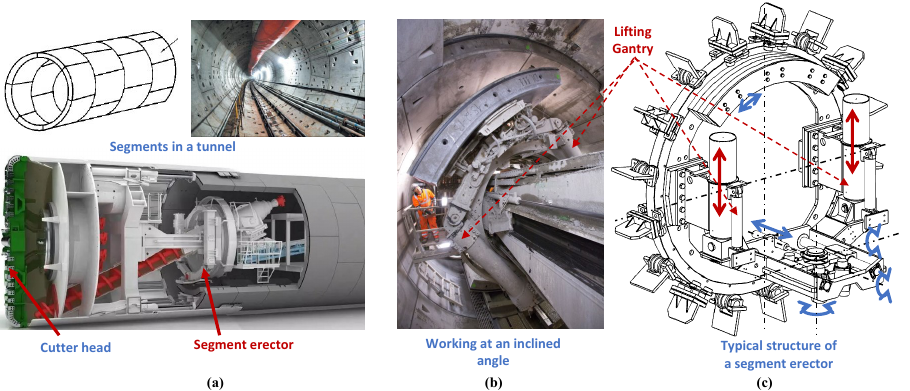
Figure 1. Background about the segment erector in a shield tunneling machine in practice. ( a ) General structures of a tunnel and a shield tunneling machine. ( b ) A segment erector in practical engineering. ( c ) The typical structure of a segment erector. This study focuses on the dual-cylinder lifting gantry in the segment erector. The lifting gantry usually works at an inclined angle, which leads to unbalanced loads on the two